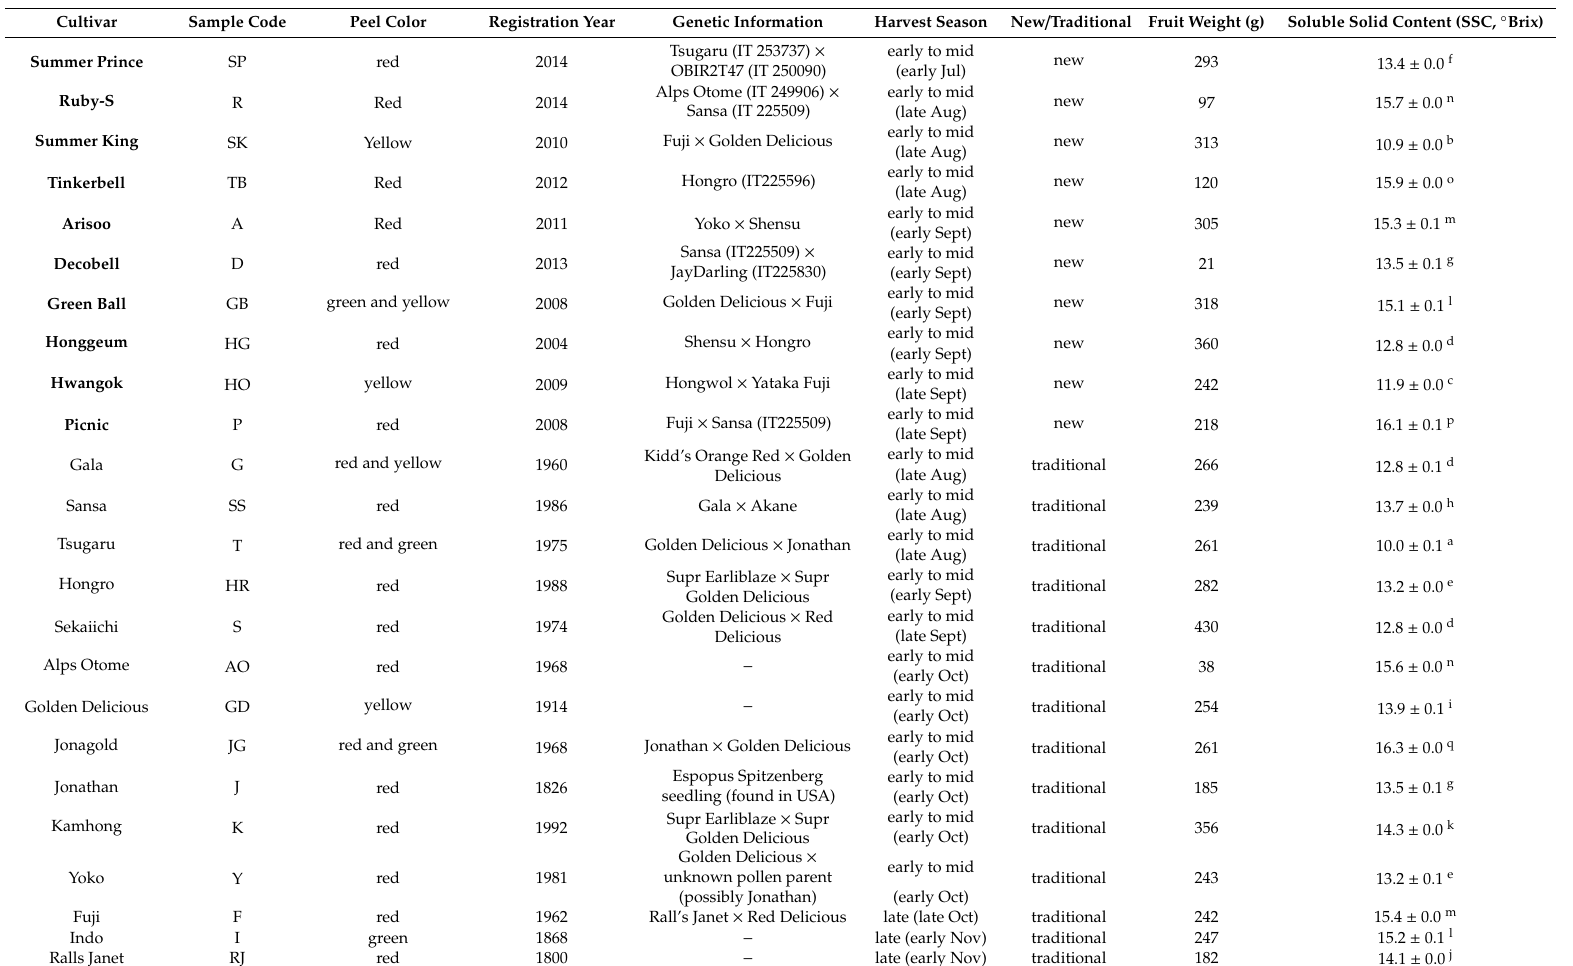
Table 1. Basic information of the 24 apple cultivars. Harvest season of early to mid and late cultivars were categorized according to Rural Development Administration